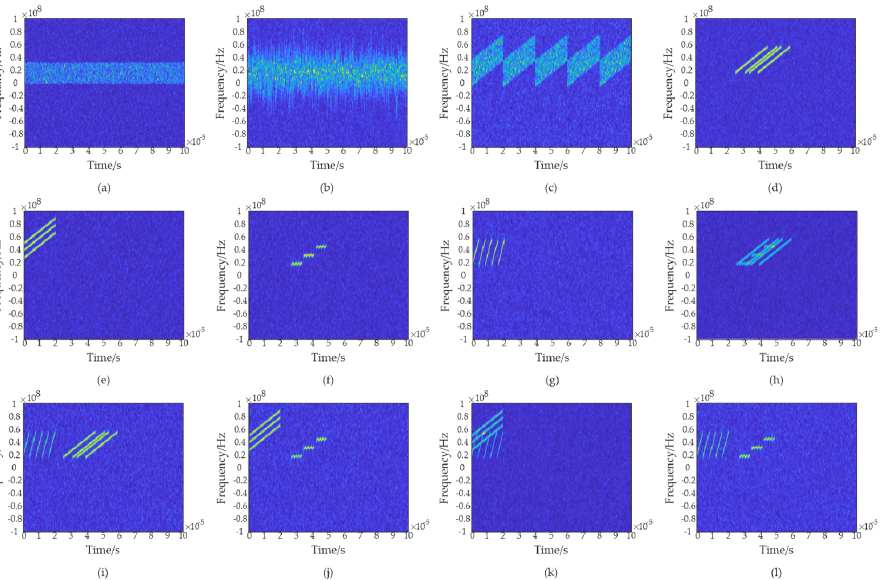
Figure 1. Time − frequency spectrograms of the above 12 jamming signals. ( a ) AJ; ( b ) BJ; ( c )SJ; ( d ) DDJ; ( e ) VDJ; ( f ) ISRJ; ( g ) SMSP; ( h ) DDJ + ISRJ; ( i ) DDJ + SMSP; ( j ) VDJ + ISRJ; ( k ) VDJ + SMSP; ( l ) ISRJ + SMSP.